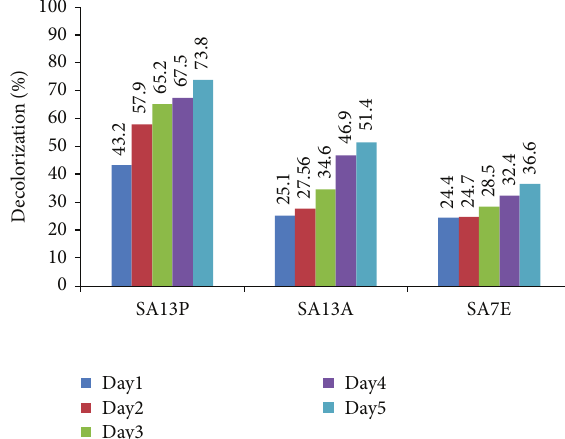
Figure 1: Graph comparing decolorization (%) of malachite green by various isolates.